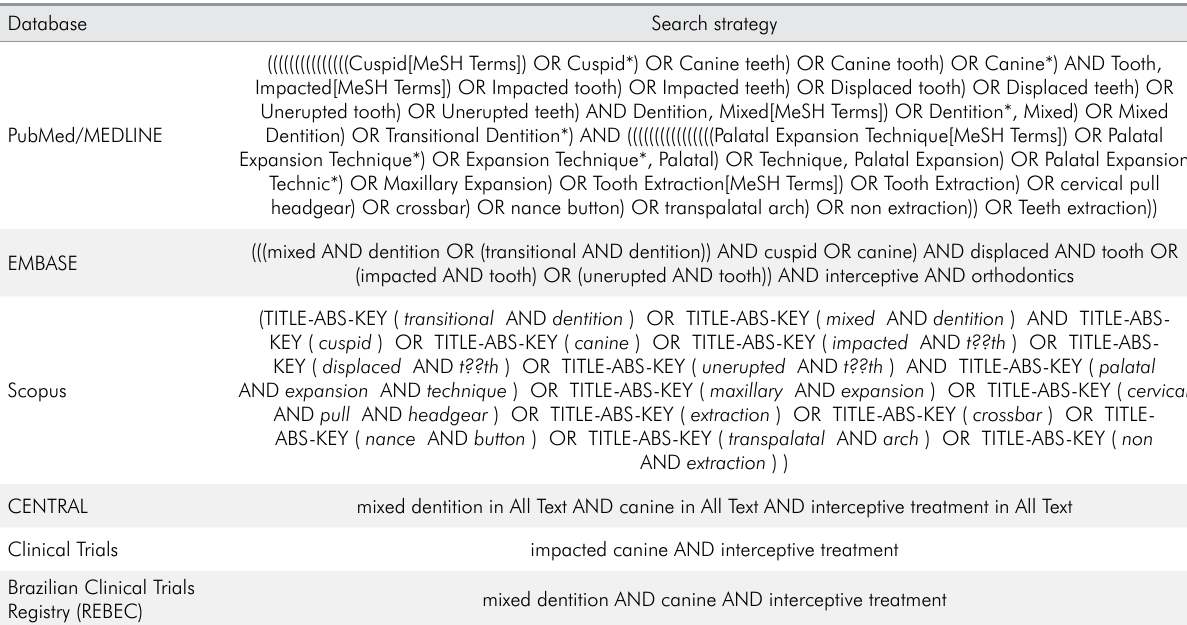
Table 1. Search strategies used for all databases